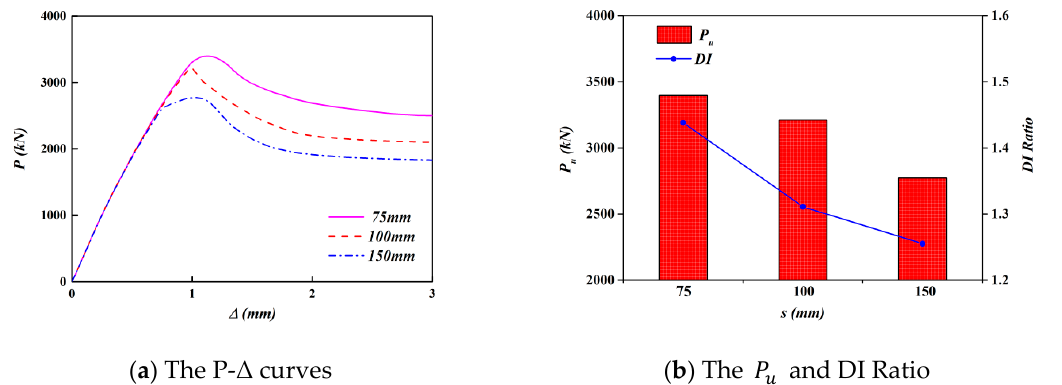
Figure 18. Influence of spacing of binding bars on compressive resistance of SDC wall.